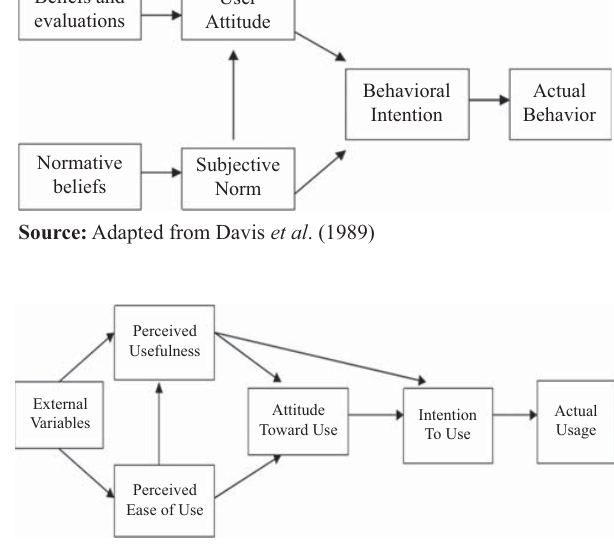
Intention To Use